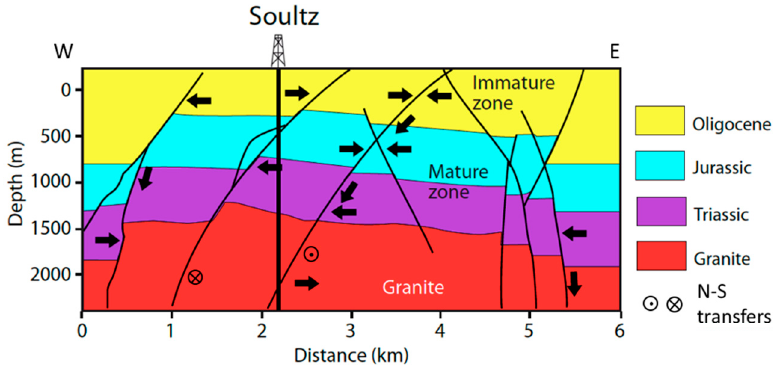
Figure 9. Scheme of organic matter migration from immature and mature zones of the sedimentary succession based on the nature of organic compounds found in the granite at a 2160 m depth. Modified from [20] and including data from [63].